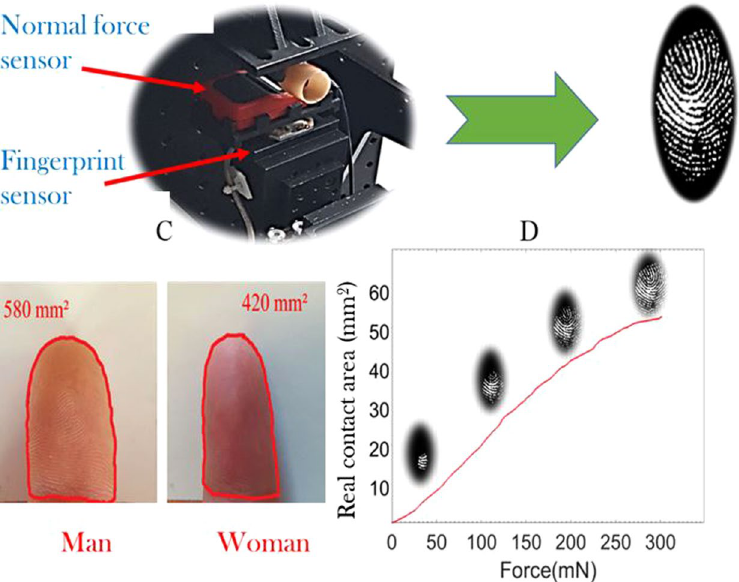
Figure 3. ( A ) A fingerprint sensor device coupled to an indentation system. Different sizes of plastic guides corresponding to the morphology of the fingers are used to properly position the finger in the center of the sensor reading area. ( B ) An image obtained with the fingerprint sensor at 0.3 N. ( C ) A photo of the finger and the contour of the first phalanx detected with the Canny filter. ( D ) The evolution of the contact area as a function of the force